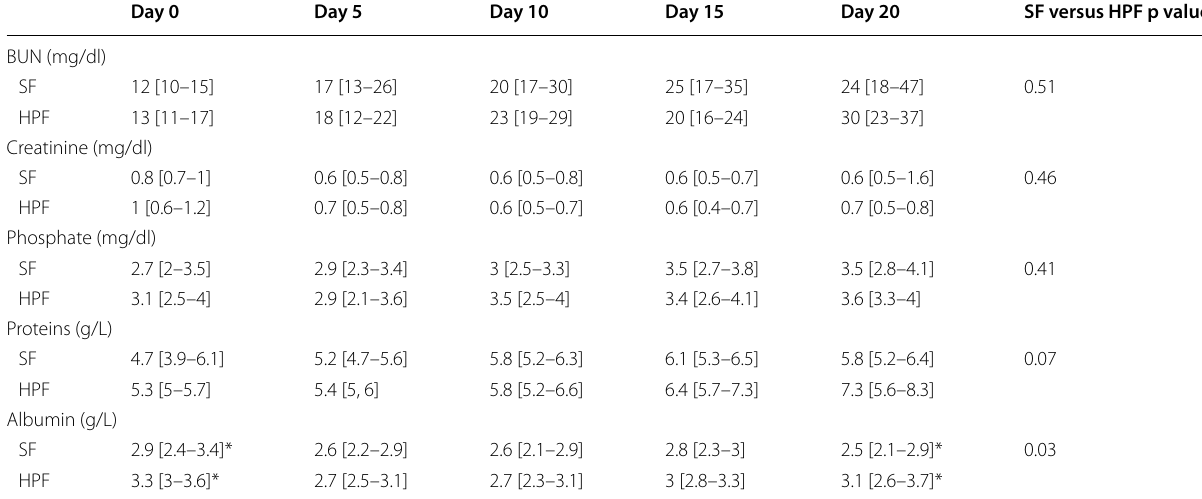
Data expressed ad median [interquartile